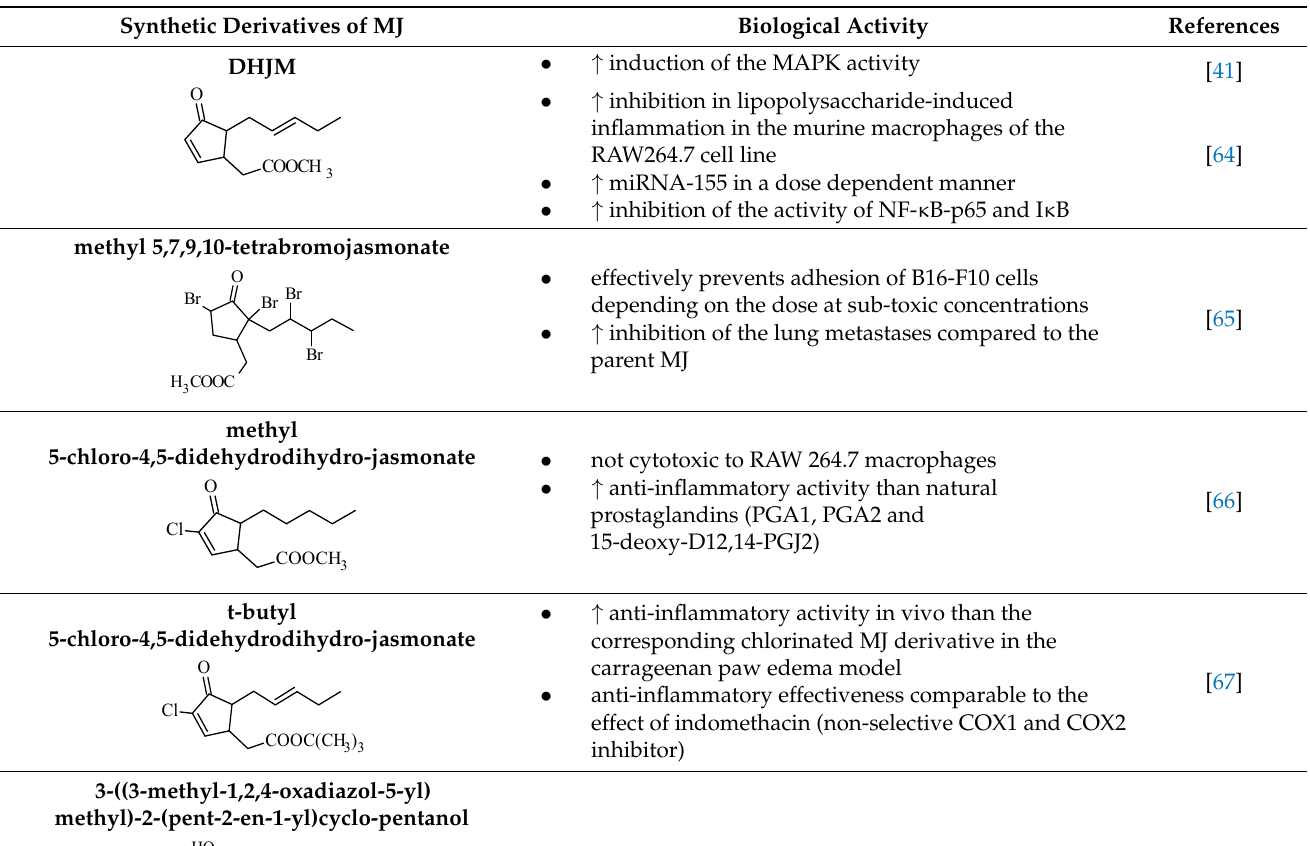
Table 3. Synthetic derivatives of jasmonates with biological properties.